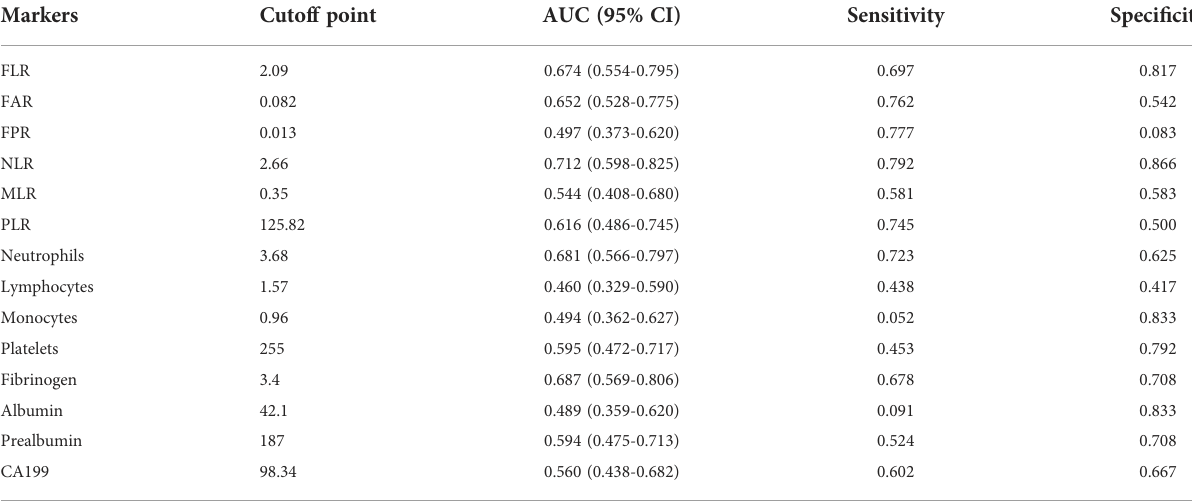
TABLE 2 ROC analyses of the in fl ammatory marker values for 5-year OS in patients with ECC.